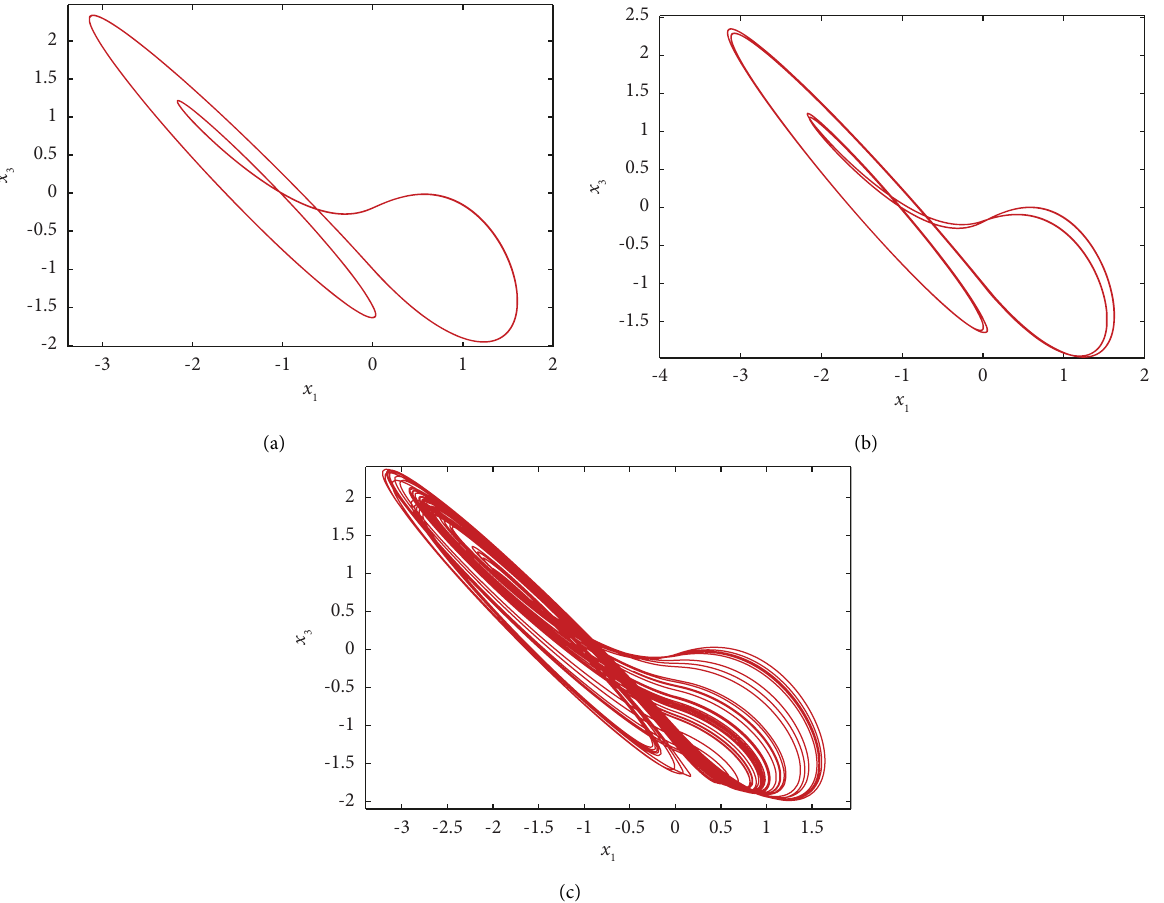
Figure 12: Types of the system phase diagrams with the change of the system initial value x ( 0 ) � − 2 . 3 is x (b) x 4